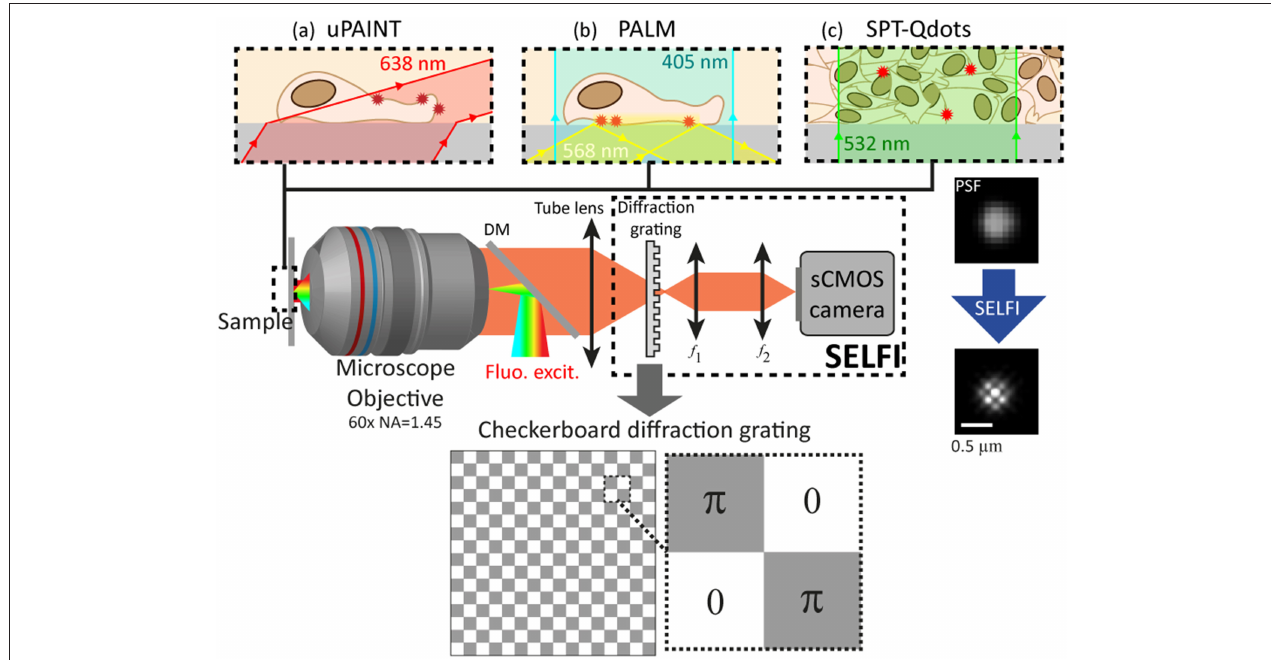
FIGURE 1 | Super-resolution imaging setup based on self-interferences (SELFI) for 3D localization in living samples. Three different configurations are shown: (a) uPAINT with highly oblique illumination at 638nm; (b) PALM with epi-photoconversion at ∼ 405nm and TIRF fluorescence excitation at 568nm; (c) SPT of Qdots in tissues excited in epi-configuration at 532nm. A scheme of the phase-only diffraction grating used in the SELFI setup is presented at the bottom. An interferometric PSF obtained with SELFI is also shown on the right. DM, dichroic mirror; f 1 , 100mm achromatic doublet; f 2 , 200mm achromatic doublet. between 10 and 40 µ m deep in the living slice. 3D stabilization was performed [30] by locking on fixed structures in the